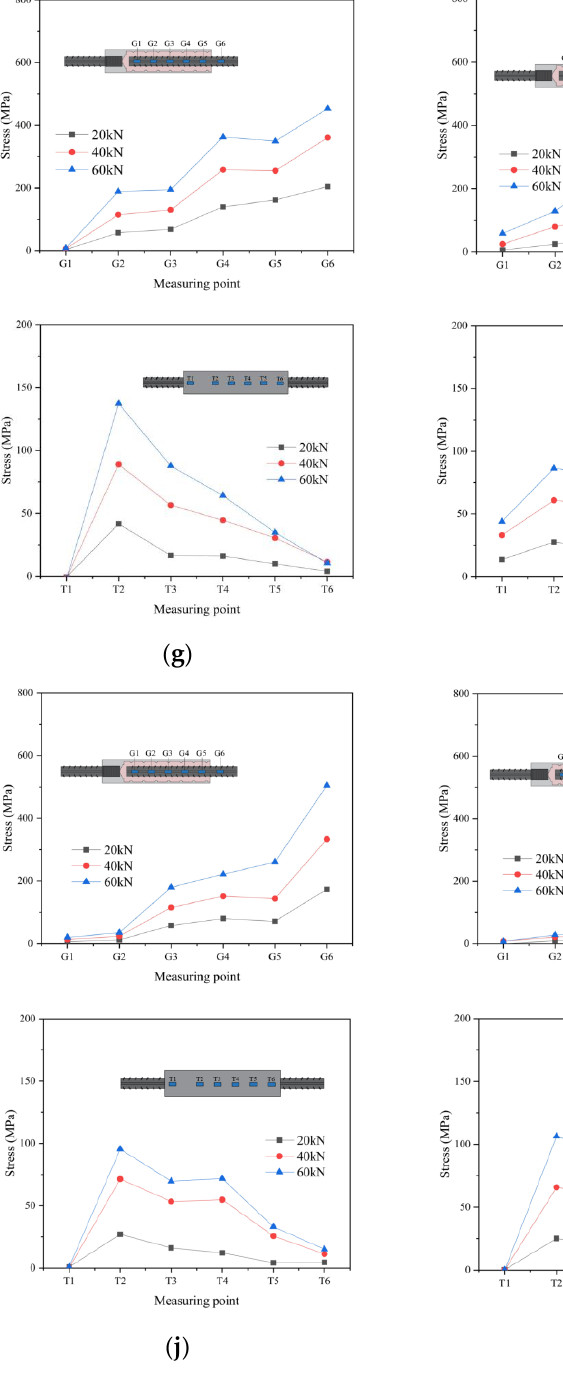
Figure 15. Stress distribution curves. ( a ) GT14-BM. ( b ) GT14-DB-2 d. ( c ) GT14-DB-2.5 d. ( d ) GT14-DB- 3 d. ( e ) GT14-ZB-2.5 d. ( f ) GT14-JB-2-2.5 d. ( g ) GT14-JB-3-2.5 d. ( h ) GT14-DC-2-2.5 d. ( i ) GT14-DC-3-2.5 d. 3 d . ( e ) GT14-ZB-2.5 d . ( f ) GT14-JB-2-2.5 d . ( g ) GT14-JB-3-2.5 d . ( h ) GT14-DC-2-2.5 d . ( i ) GT14-DC-3-2.5 d . ( j ) GT14-SP-2mm. ( k ) GT14-SP-4mm. ( j ) GT14-SP-2mm. ( k )